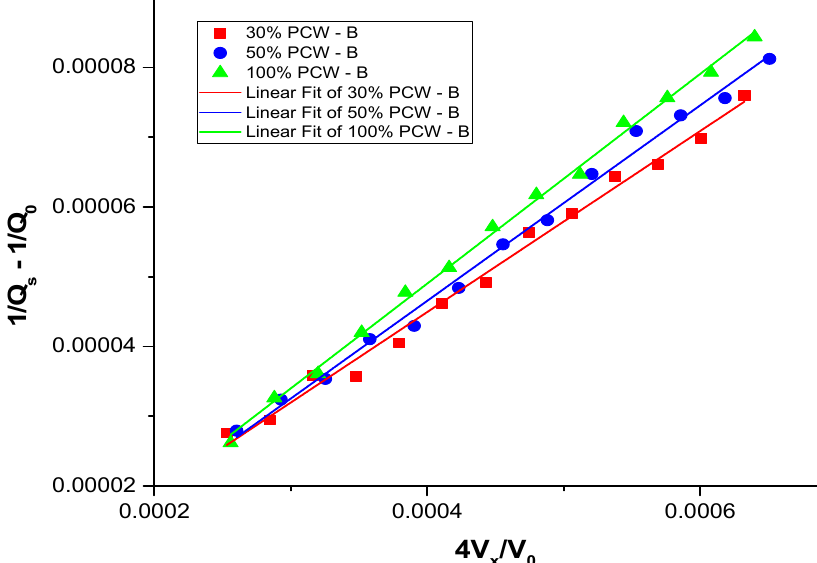
Figure 5. Plots of Equation 1b for ε r ” of three o ffi ce papers of varying PCW recycled fiber content (30%, 50%, and 100%) produced by manufacturer B. Solid lines are linear fits through the data